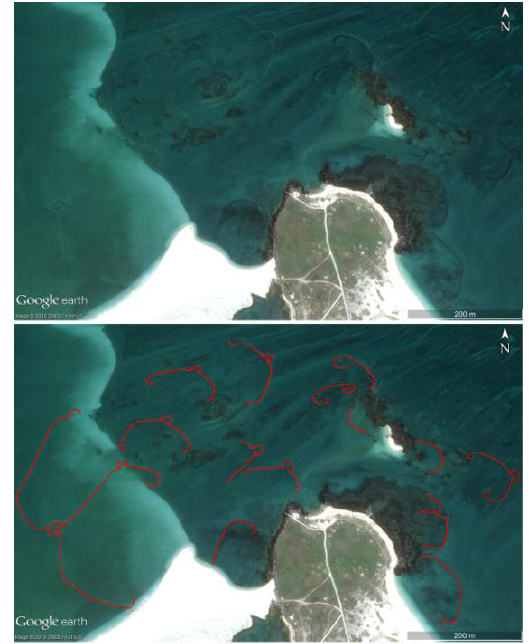
Figure 1. GeoEye-2 image (© GeoEye Image Copyright 2015, DigitalGlobe) from GoogleEarth Pro (upper) and red polylines indicate manual extractions of STWs (lower)